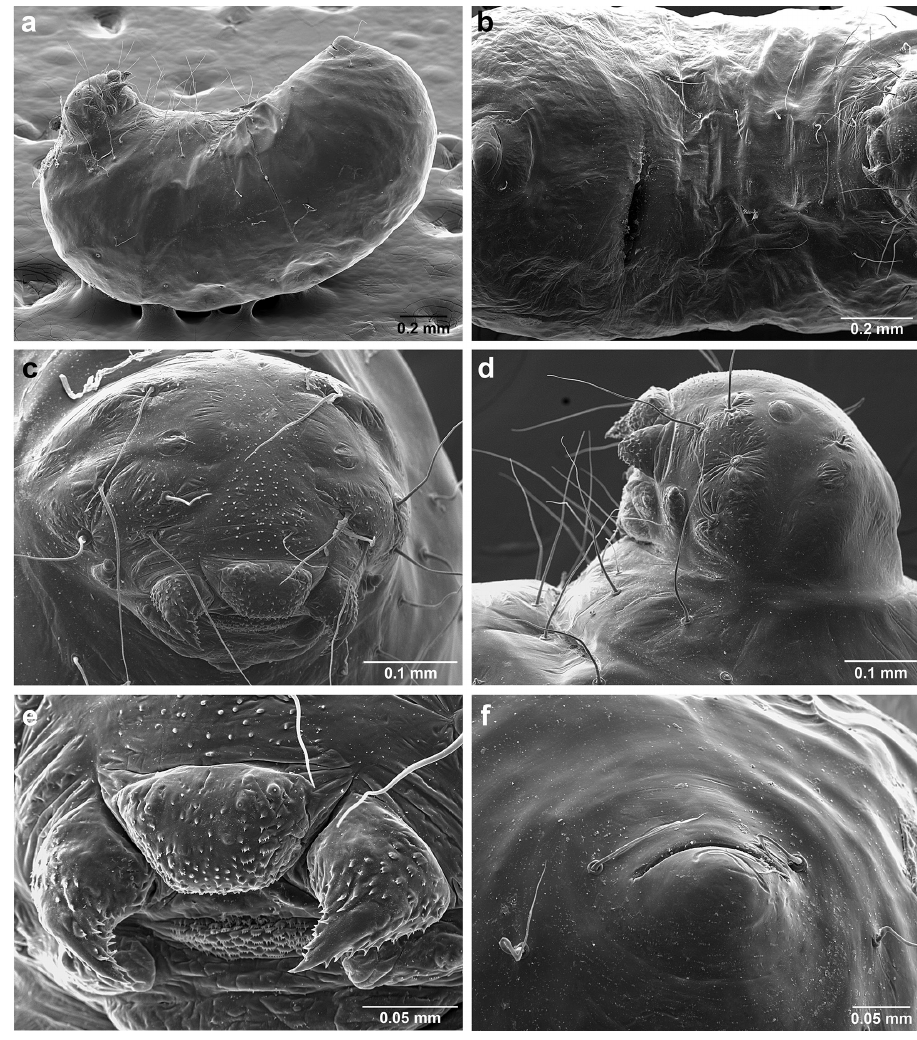
Figure 26. S. bondari larva (USNMENT01125807), SEM images. a Lateral view b ventral view c head, frontodorsal view d head, lateral view e mouthparts f anal